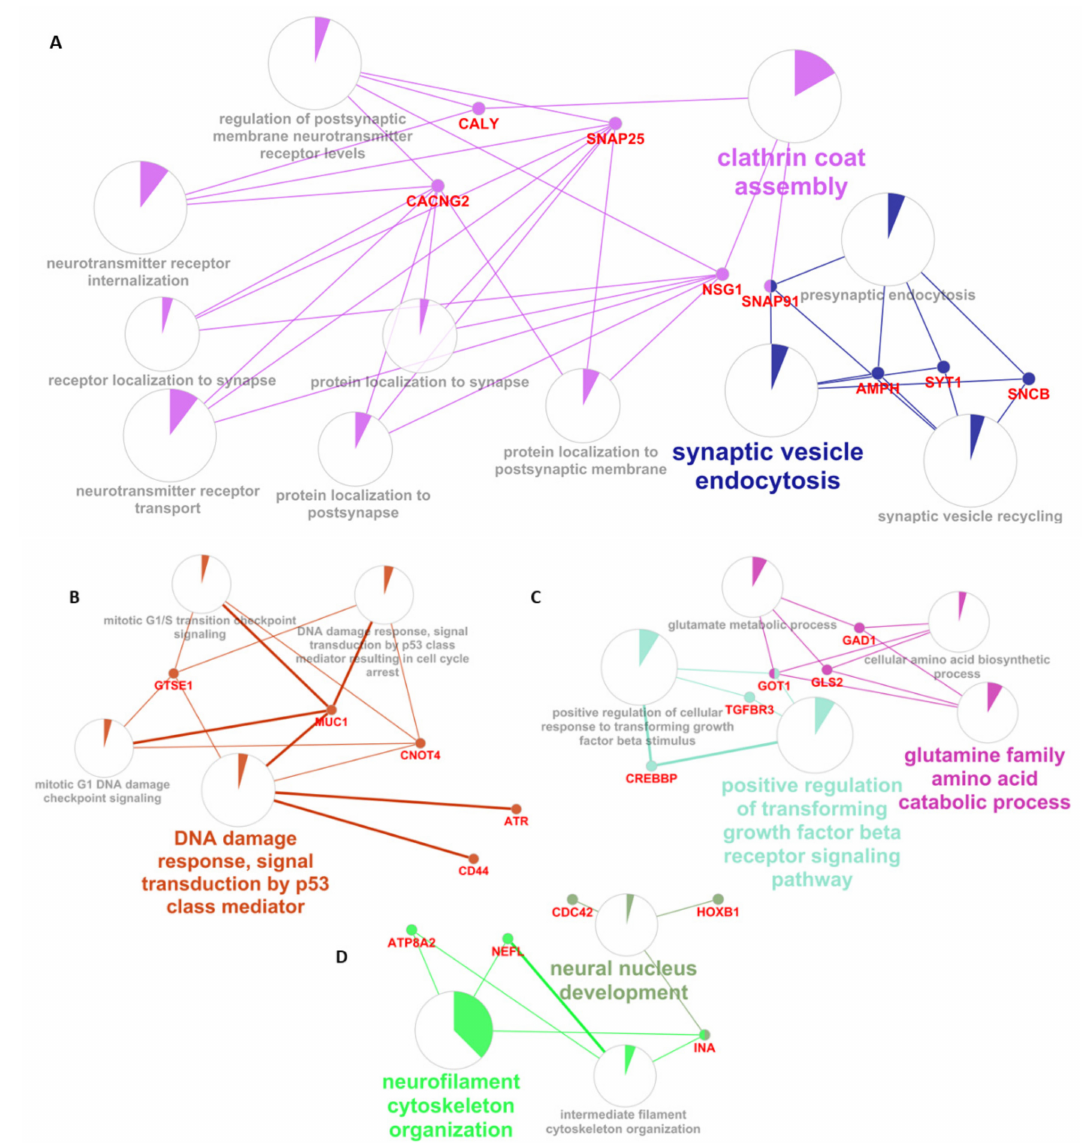
Figure 5. Pathway analysis using ClueGo from 64 genes obtained with WGCNA. Nodes represent GO terms and the node size represents the term’s enrichment significance. ( A ) Clathrin coat assem- bly and synaptic vesicle endocytosis; ( B ) DNA damage response signal transduction by p53 class mediator; ( C ) positive regulation of transforming growth factor beta receptor signaling pathway and glutamine family amino acid catabolic process; ( D ) neurofilament cytoskeleton organization and neural nucleus